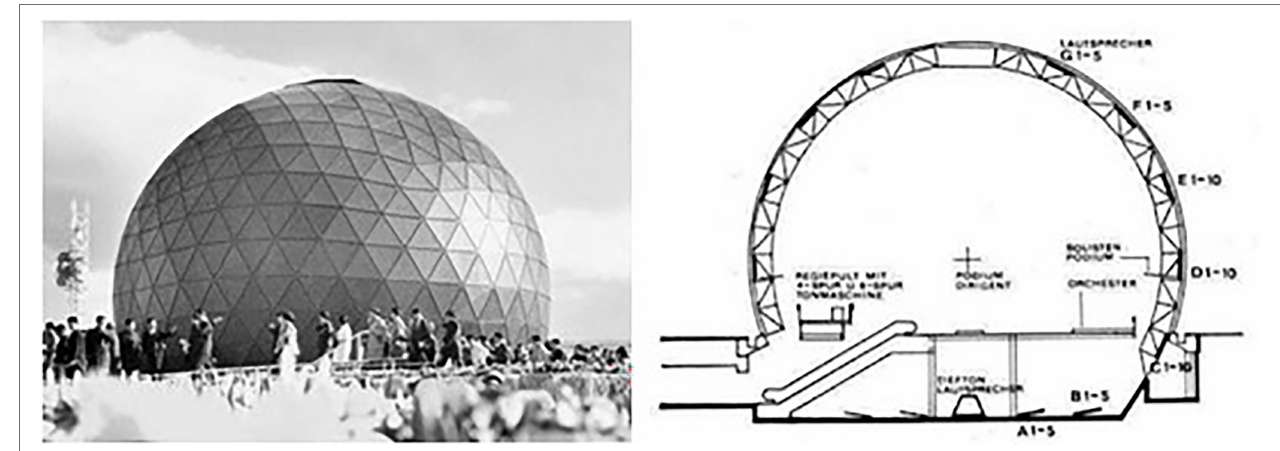
FIGURE 4 | Left: Stockhausen’s spherical concert hall created for the World’s fair Expo ‘70 (1970) viewed from outside (Stockhausen, 1970a,b). © Karlheinz Stockhausen. Right: Lateral cut of the spherical concert hall. © Stockhausen-Stiftung für Musik, Kürten (http://www.karlheinzstockhausen.org). Images reproduced with permission.